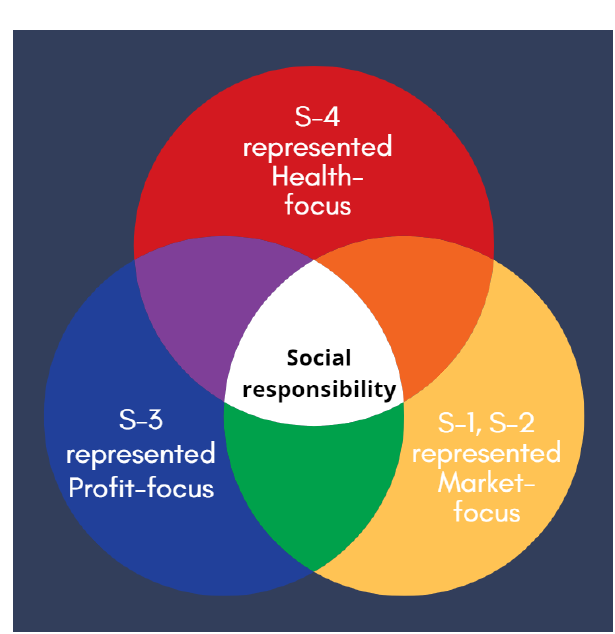
Figure 9. Comparison of focus between suppliers and producers.